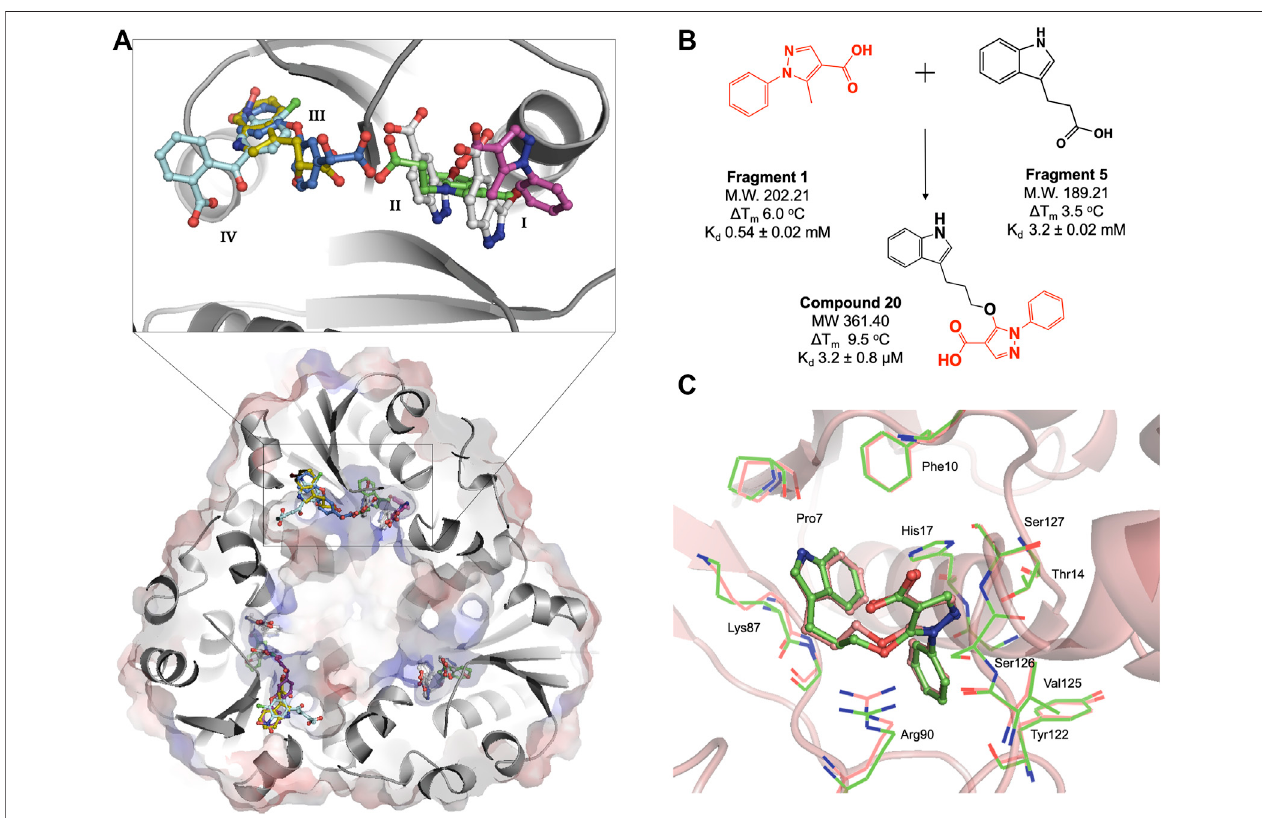
FIGURE 3 | (A) Structural superposition of six representative M. abscessus PPAT crystal structures bound to fragments 1 (purple), 2 (white), 3 (green), 4 (blue), 5 (gold)and 6 (turquoise),showingfragmentsoccupyingfourdistinctregionsinthePPATactivesite. Mab PPATisshownassurfaceelectrostaticrepresentationandgrey cartoon model. (B) Fragment linking scheme leading to compound 20 , originally designed to target M. tuberculosis PPAT and the corresponding biophysical data (thermal shift ( Δ T m ) and binding af fi nity (K d ) for M. abscessus PPAT ortholog, determined in this study (C) Superposition of compound 20 bound Mab PPAT (salmon) PDB code 7YYZ and Mtb PPAT (green), PDB code 6QMH structures showing close similarities in overall binding mode at the enzyme adenyl